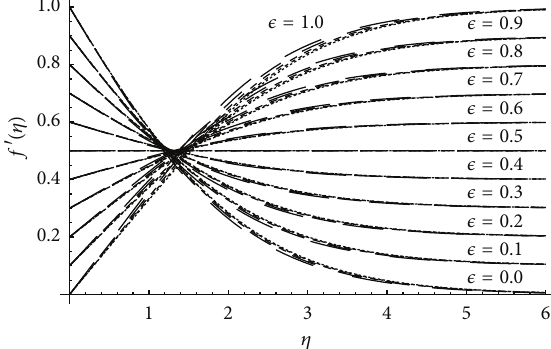
Figure 2: The fluid velocity for the class of the Blasius problem at different values of 𝜖 using 7, 9, 11, 13, and 15 terms of the current